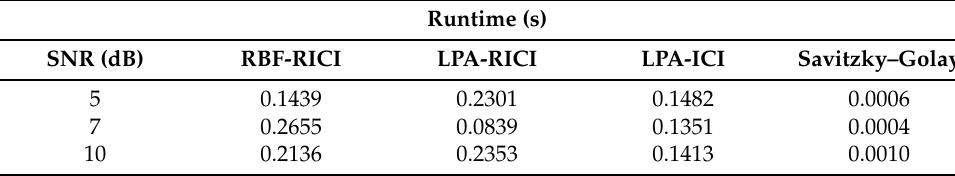
Table 7. Blocks signal—Filtering algorithms’